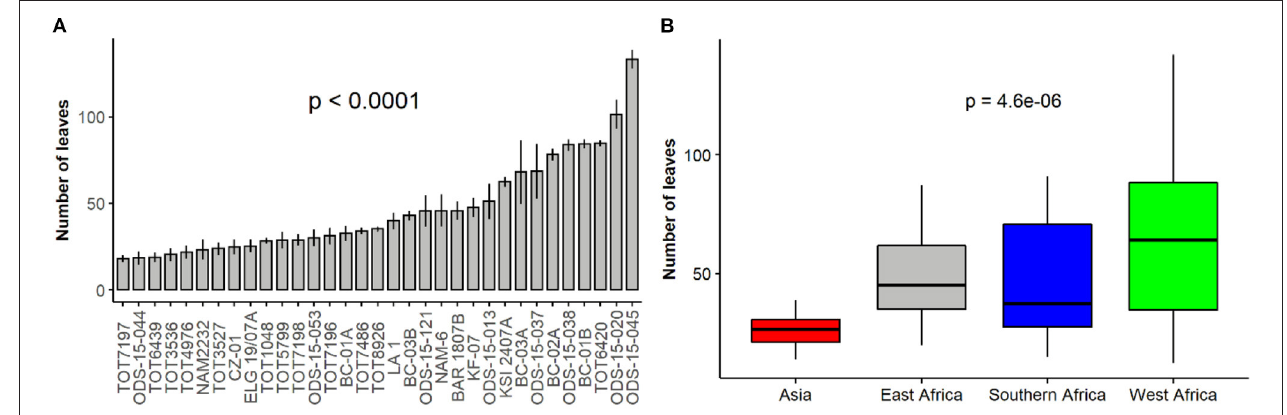
FIGURE 4 | Variation in the number of leaves among 33 accessions (A) and based on their regions of origin (B) of a collection of Gynandropsis gynandra .